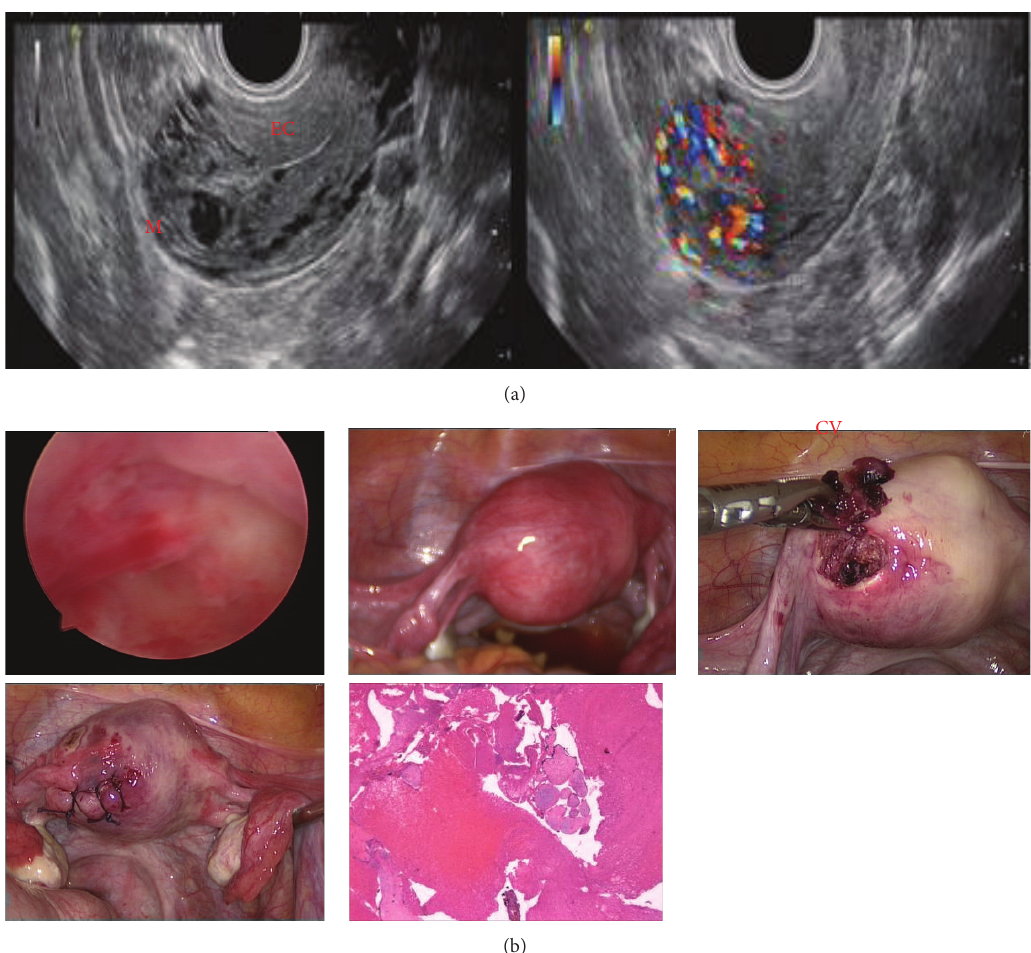
Figure 1: (a) Color Doppler transvaginal sonography of the transverse view of the uterus showing an endometrial cavity (EC) and mass (M). (b) Hysteroscopy reveals an empty uterine cavity without gestational tissue. Laparoscopic findings showing an intramural pregnancy near the left fundus. Histological specimens showed that chorionic villi (CV) were identified in the intramural